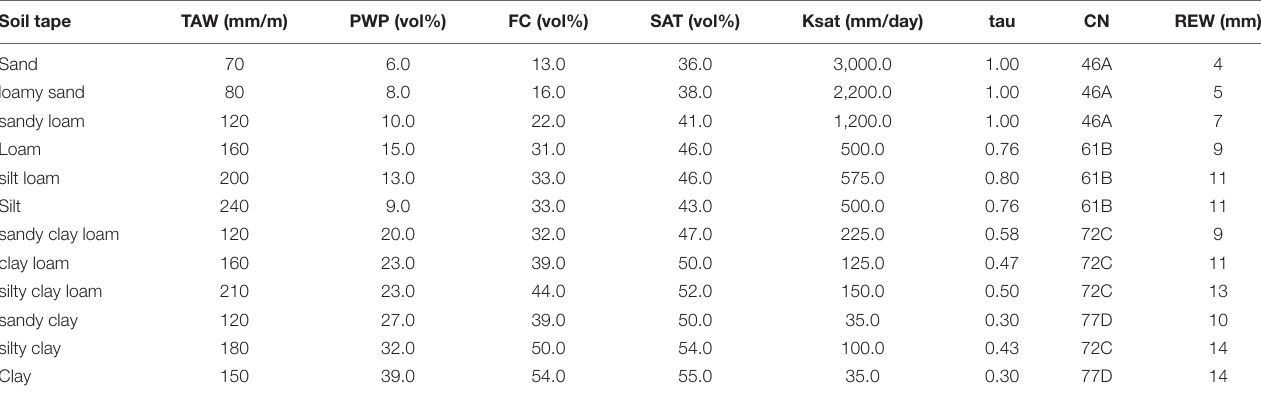
FIGURE 5 | Flowchart of the methodology applied. TABLE 4 | AquaCrop model soil database (Van Gaelen and Raes,